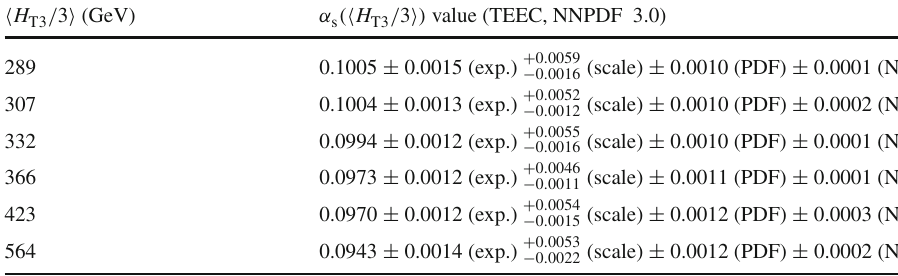
Table 10 Values of α s , obtained from TEEC fits, evolved to the average value of transverse momentum for every pair of jets in each event, (cid:4) ( p T i + p T j (cid:5) / 2 for each bin in H T2